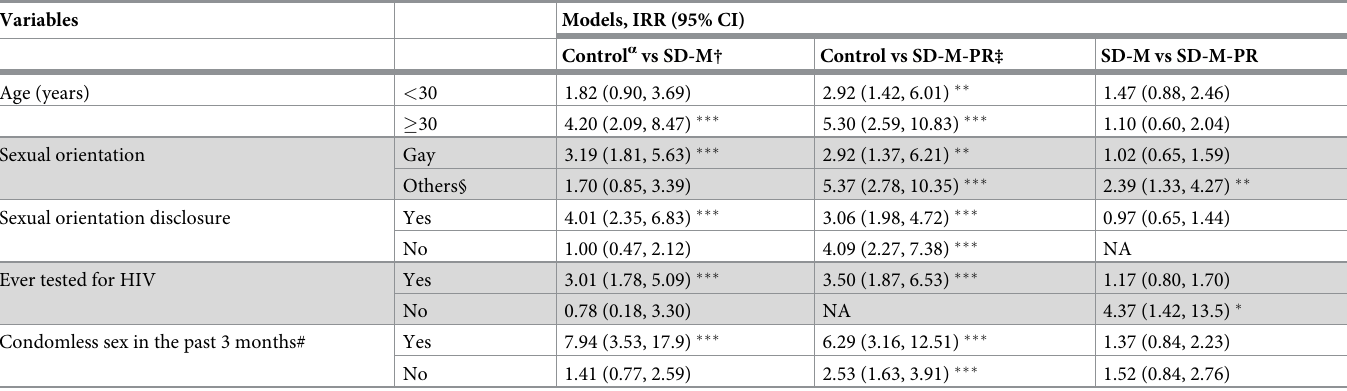
Table 3. Subgroup analysis of 309 index participants regarding the total number of motivated unique alters in China at the end of the study, 2019 to 2020.